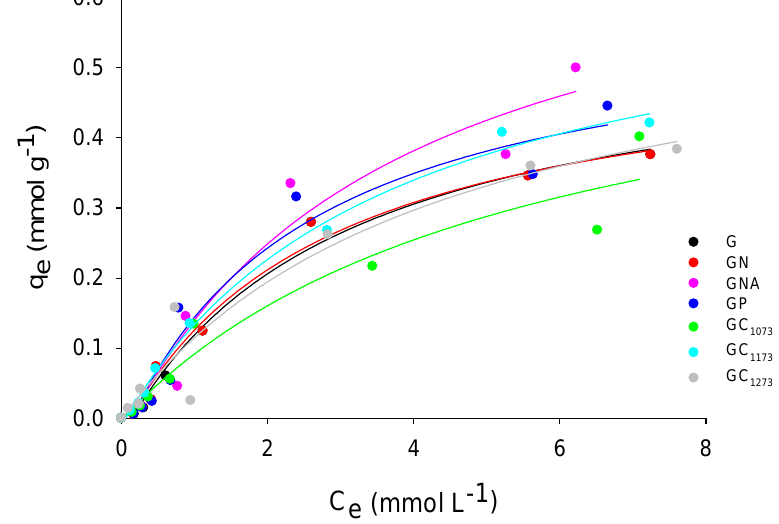
Figure 4. The adsorption isotherms of phenol from aqueous solution for the adsorption process in the calorimeter. The lines correspond to the adjustment of the data in the Langmuir Modified Model.